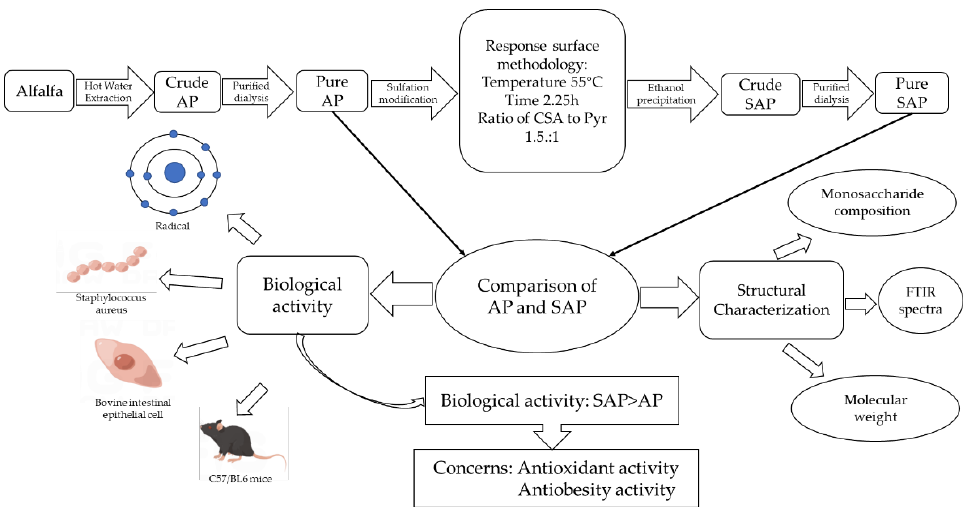
Figure 1. Overview schematic of the study.